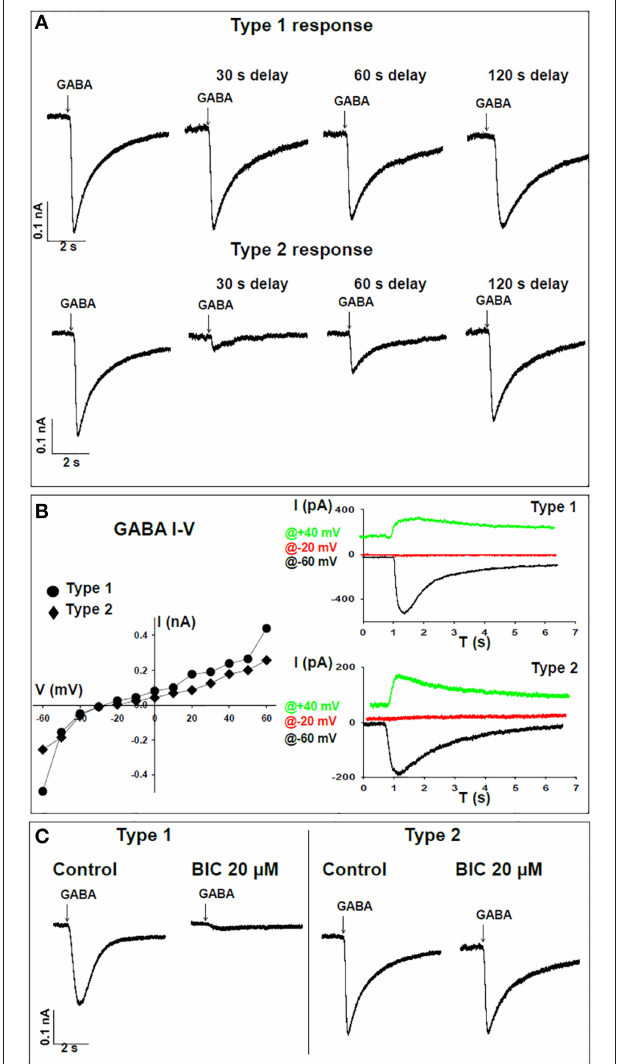
FIGURE 2 | Time-dependent responses of WT neurons to GABA. (A) Representative traces of voltage-clamp recordings for time-dependent responses to GABA demonstrating “type 1” (top) and “type 2” (bottom) patterns. Cells were held at -60mV and 2mM GABA was applied by pressure from an adjacent pipette. Recordings were taken for the first puff and following consecutive delays of 30, 60, and 120 s. (B) Left panel, I-V curve for type 1 (circles) and type 2 (diamonds) GABA responses in single neurons. Right panel, representative traces corresponding to the same neuron shown on the left. Traces are sown for recordings at − 60mV (black), − 20mV (red), and + 40mV (green). (C) Representative traces of voltage-clamp recordings showing sensitivity to 20 µ M bicuculline (BIC) in type 1 (WT n = 6 , FX n = 1 ) and lack of sensitivity to BIC in type 2 (WT n = 5 , FX n = 8 ) responses to